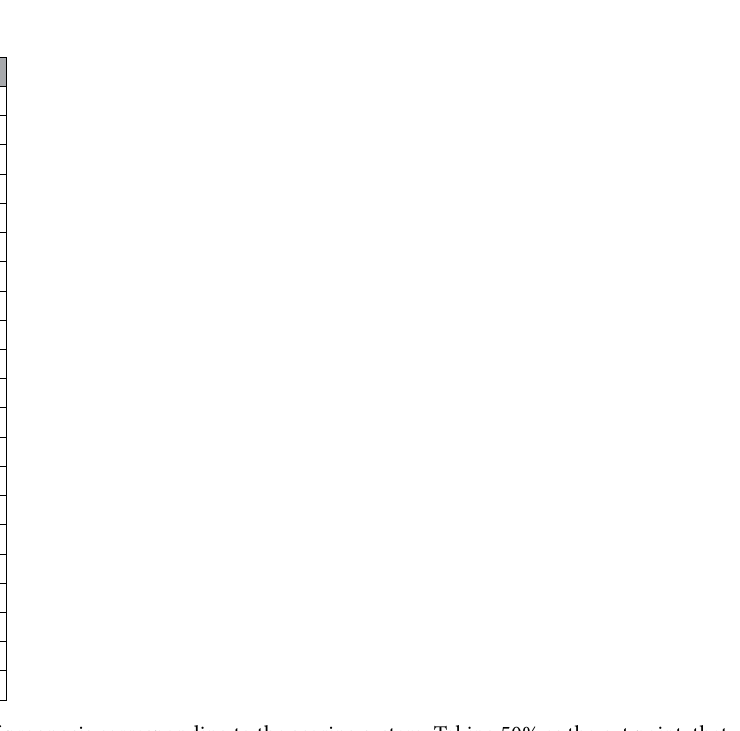
Table 5. The probability of prognosis corresponding to the scoring system. Taking 50% as the cut point, that is, the patient’s score is greater than 231, which means that the patient will have PTE. The prediction accuracy of the above scoring system is 98.29%. The confidence interval of the C-index is 97.28% to